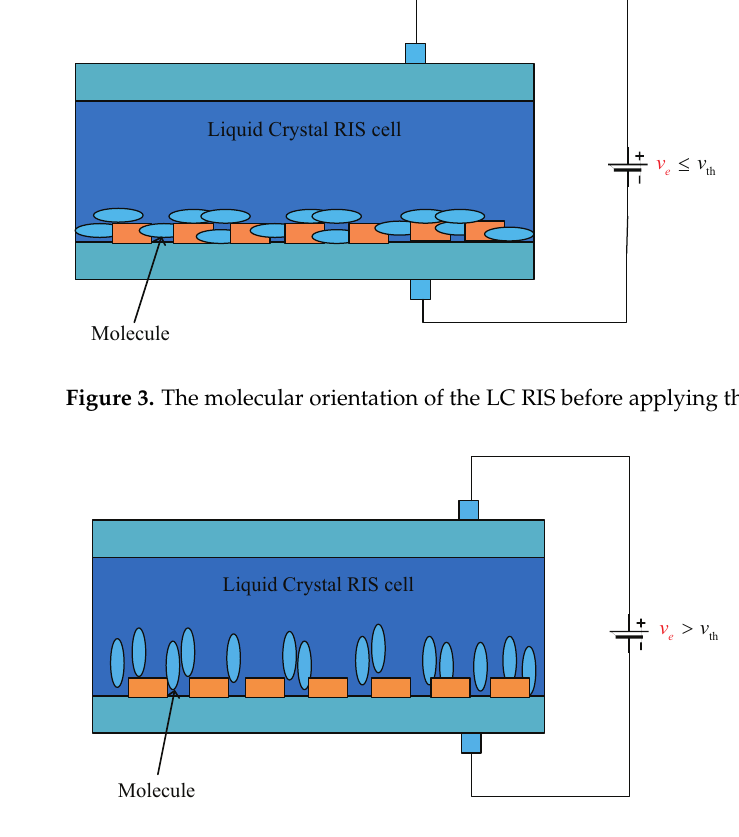
Figure 4. The molecular orientation of the LC RIS after applying the